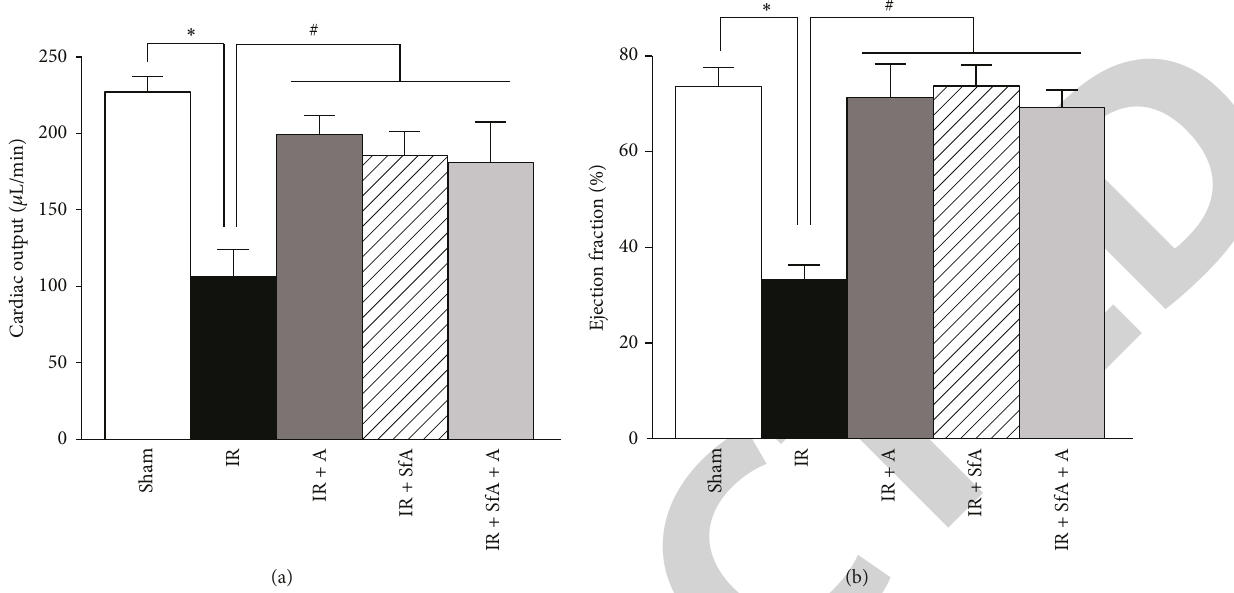
Figure 2: Effects of A-769662 (A) and/or SfA on cardiac output (a) and ejection fraction (b) of hearts after IR or Sham procedure. Calculations ofcardiacoutputandejectionfractionaregiveninSection2.Thenumberofanimals:Sham( 𝑛 = 7 ),IR( 𝑛 = 8 ),IR+SfA( 𝑛 = 4 ),IR+A-769662 ( 𝑛 = 6 ), and IR + SfA + A ( 𝑛 = 4 ). ∗ 𝑃 < 0.01 versus Sham; # 𝑃 < 0.01 versus